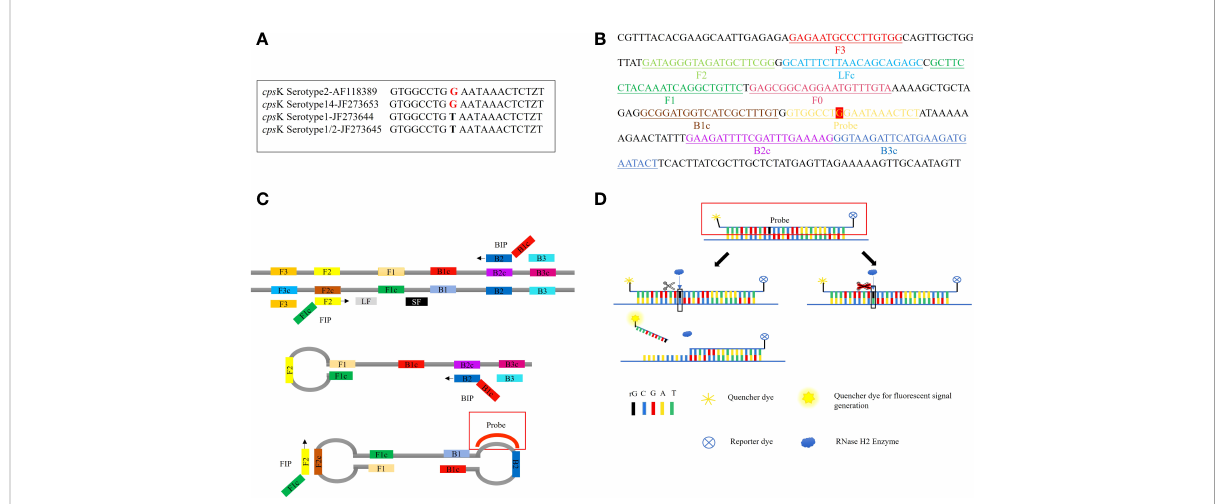
FIGURE 1 Principle of the LP-LAMP Method. (A) Single-nucleotide polymorphism at the 483rd site of the cps K gene for serotype 2, serotype 14, serotype 1, and serotype 1/2 Streptococcus suis . (B) Schematic diagram of the cps K gene showing the position and composition of LP-LAMP primers and probe. (C) The principle of the LP-LAMP method. (D) The working principle of the loop primer